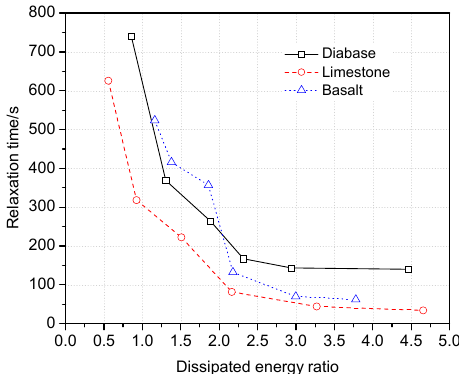
Figure 14. Relationship between the dissipated energy ratio and relaxation time.